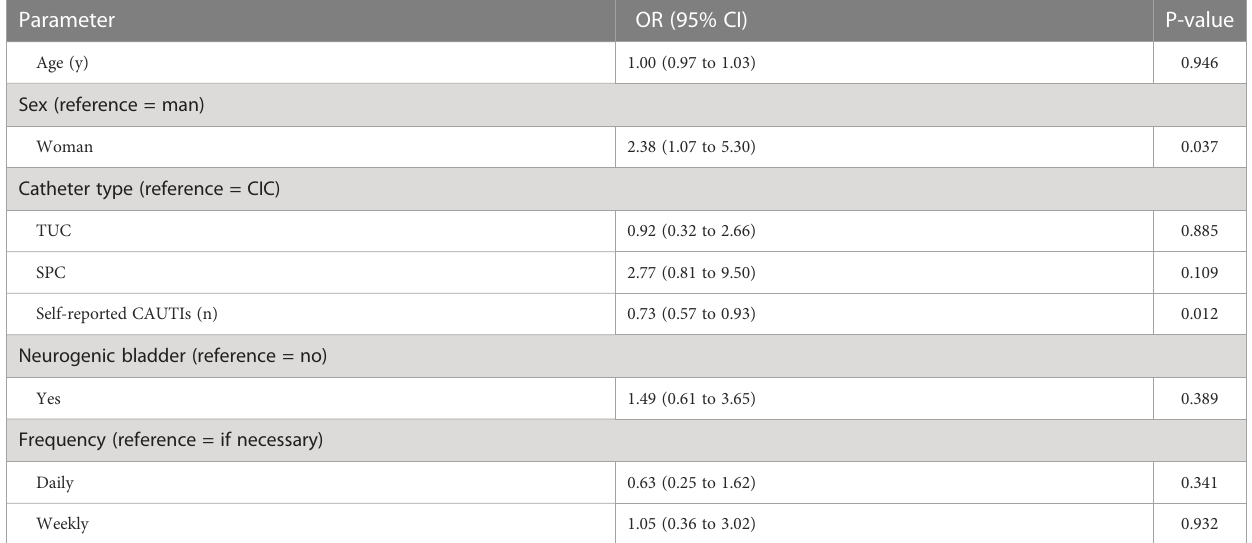
TABLE 3 Multivariable ordinal logistic regression analysis of factors associated with overall treatment satisfaction.